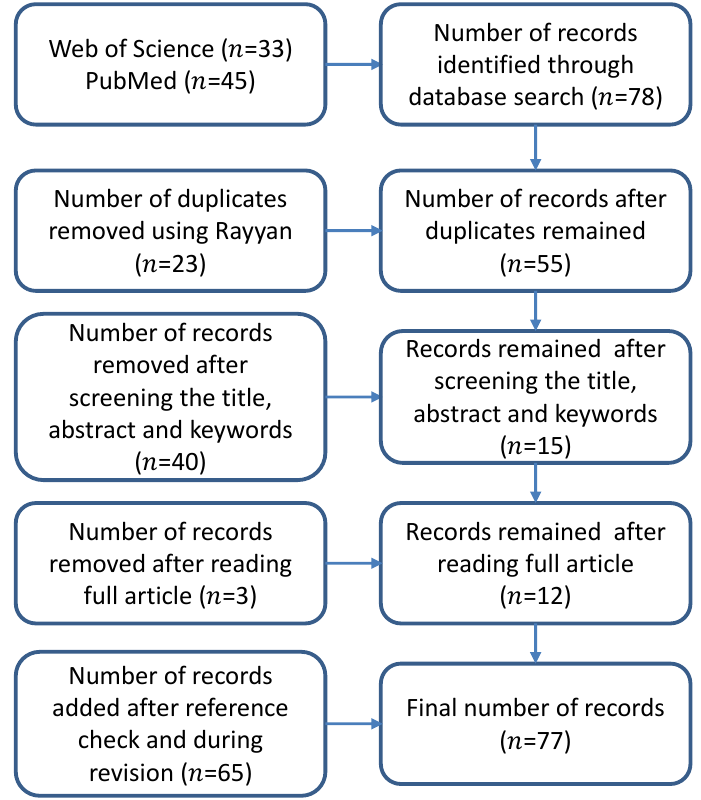
Figure 2. Flowchart of the literature review article selection